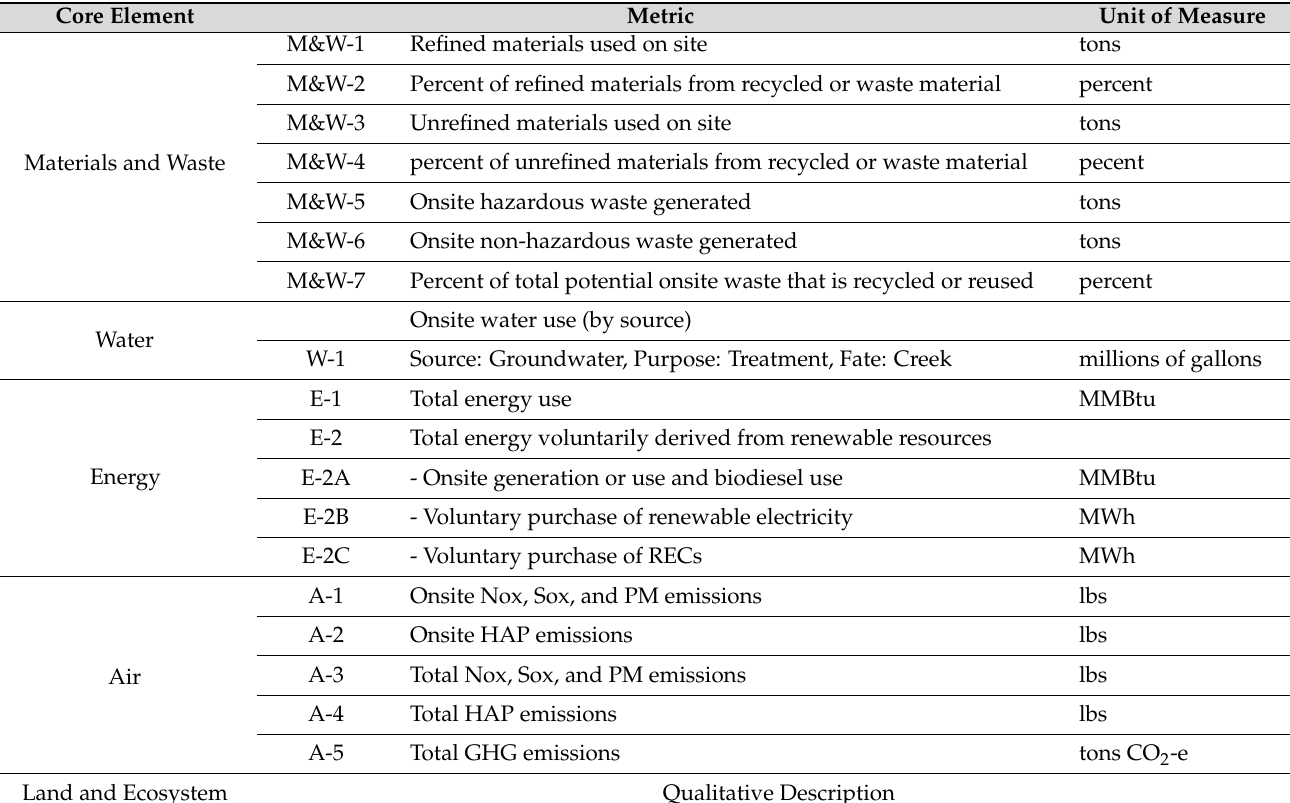
Table 2. Green remediation metrics (modified from